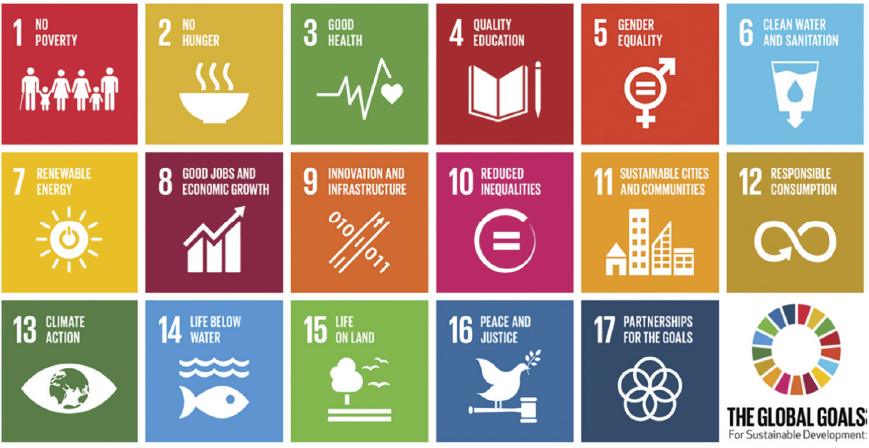
Figure 1. The 2030 agenda for sustainable development [32]